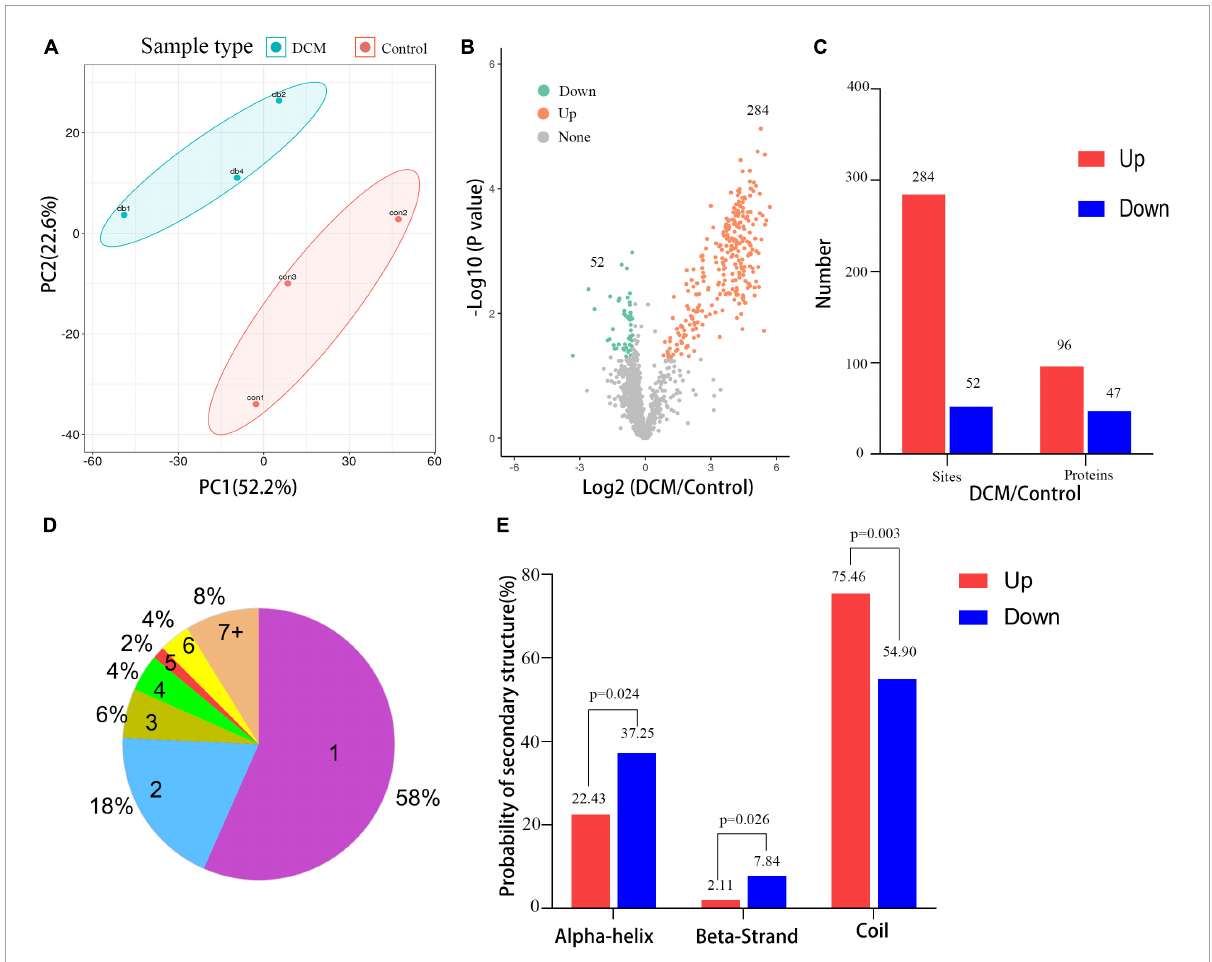
FIGURE3 Quantitative signatures of different lysine β -hydroxybutyrylation (kbhb) sites in heart tissue of diabetic cardiomyopathy (DCM) rats. (A) Principal component analysis (PCA) was performed based on the log 2 -transformed intensity of proteins identified in the three replicates ( n = 3 rats per group). (B) Volcano plot graphs representing the comparative analysis between the DM group and control group. The X-axes correspond to the ratio of intensities in the log 2 scale for each protein in the two samples, and the Y-axes are the p -value in the log 10 scale. Blue dots represent proteins downregulated in DM rats, and orange dots correspond to proteins upregulated in DM rats. (C) The number of lysine β -hydroxybutyrylation (kbhb) sites and proteins. (D) The number and percentage of β -hydroxybutyrylation residues per protein. (E) Analysis of the secondary structure of the β -hydroxybutyrylated